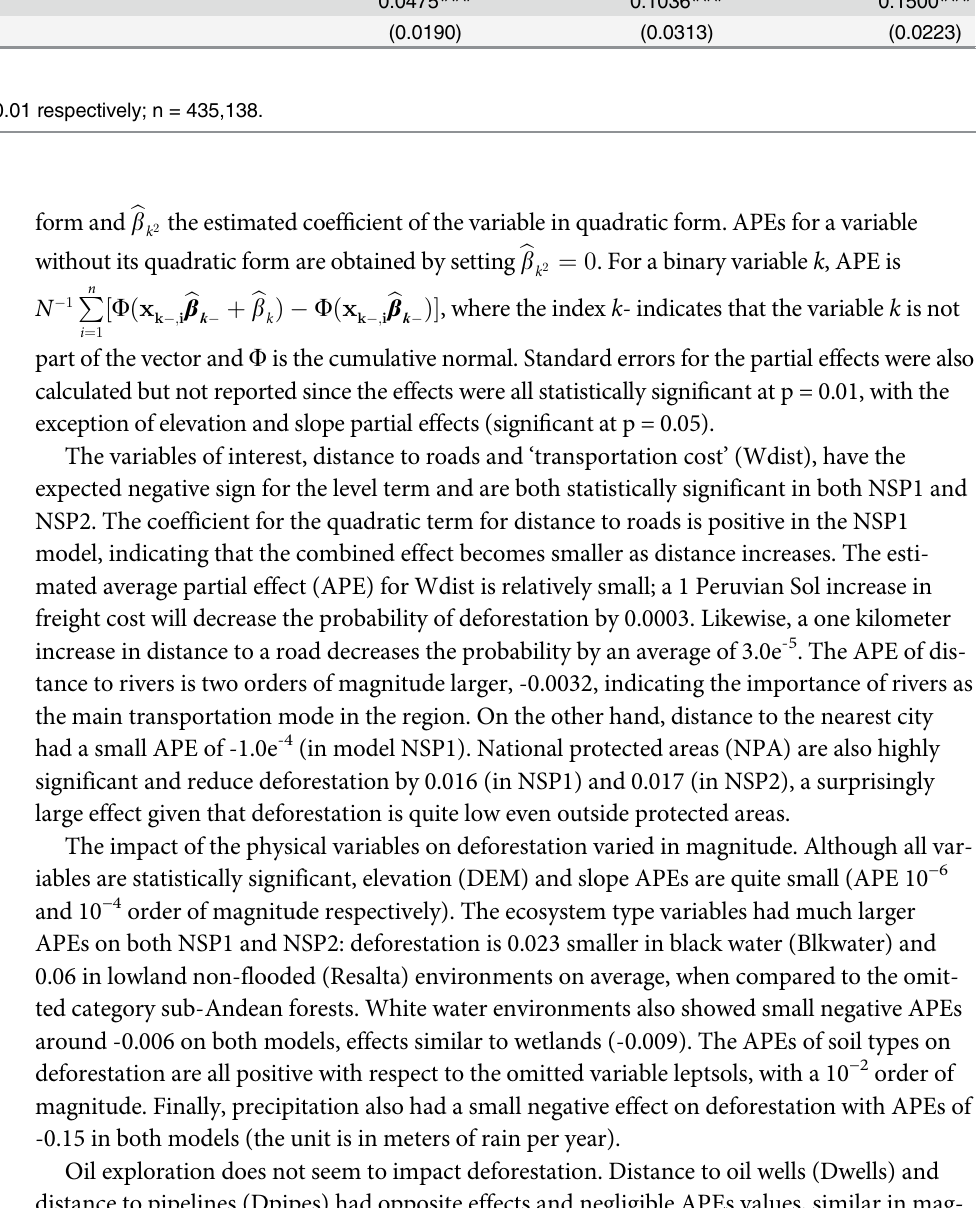
b b ¼ 0 . For a binary variable k , APE k 2